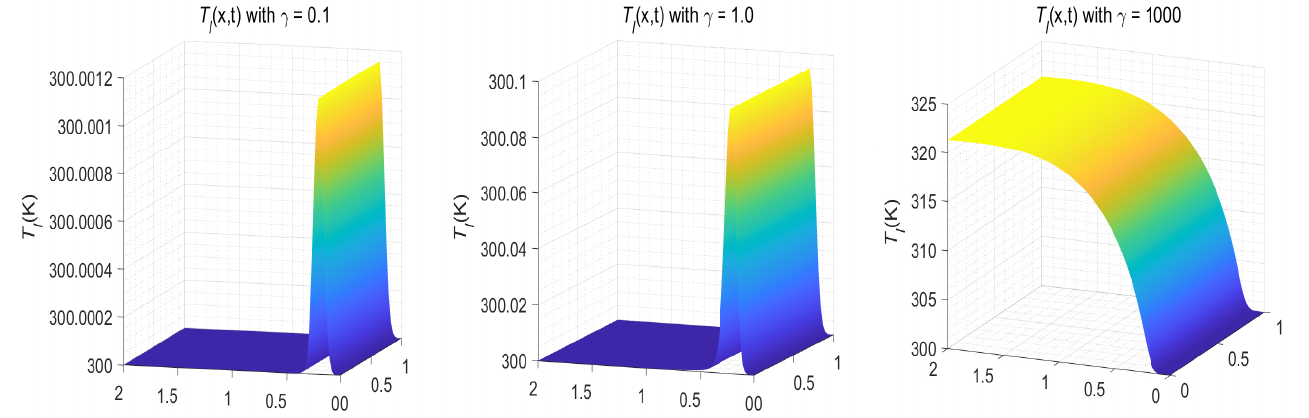
Figure 15. Temperature distributions of T l versus ( x , t ) with various γ when K n = 618.4658, ( α , β ) = ( 0.9,0.9 ) , N = 100, and M = 100 for Example 2.